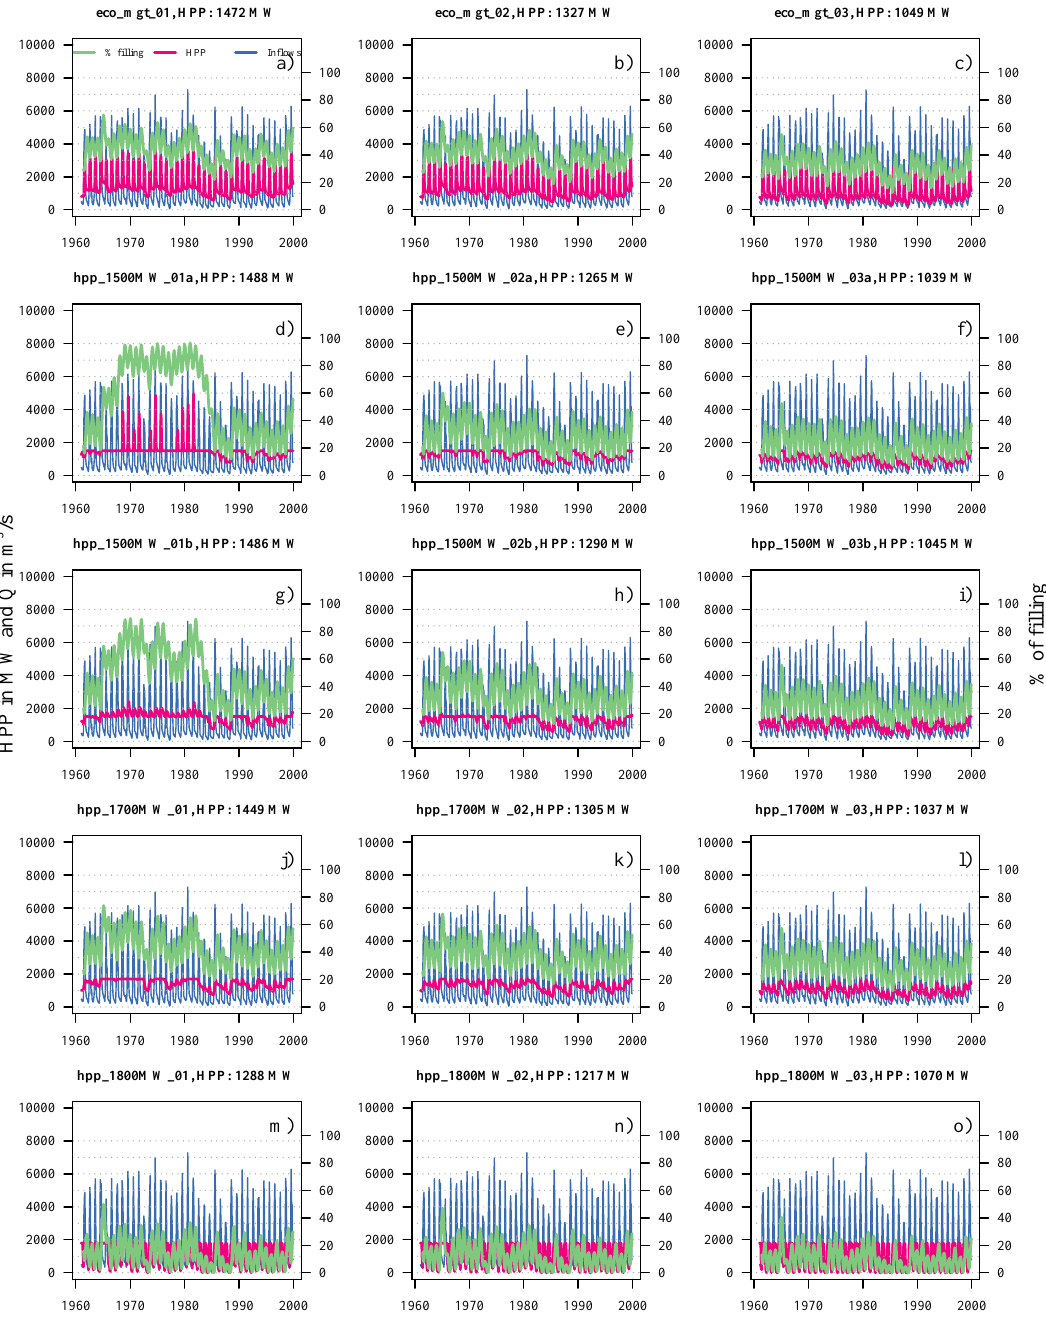
Figure 8. Reservoir filling, inflows and Hydroelectric Power Production (HPP) of all simulated operation scenarios under the reference climate using Watch Forcing Data (WFD). Rows represent the same management scenarios and columns seepage scenarios. Left = “low”, middle = “medium” and right = “high” seepage